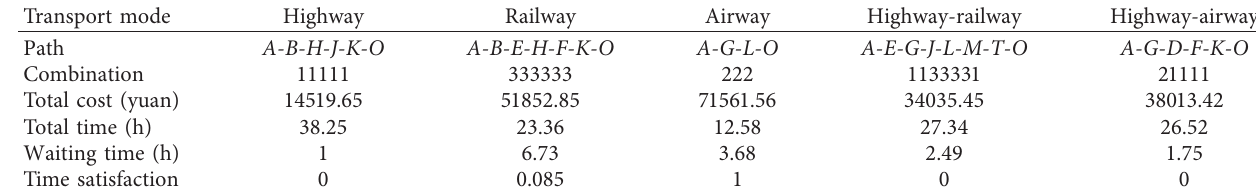
Table 5: Optimal path decisions under different freight transport